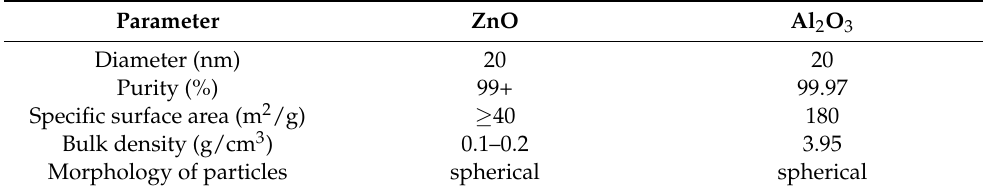
Table 2. Technical parameters of used